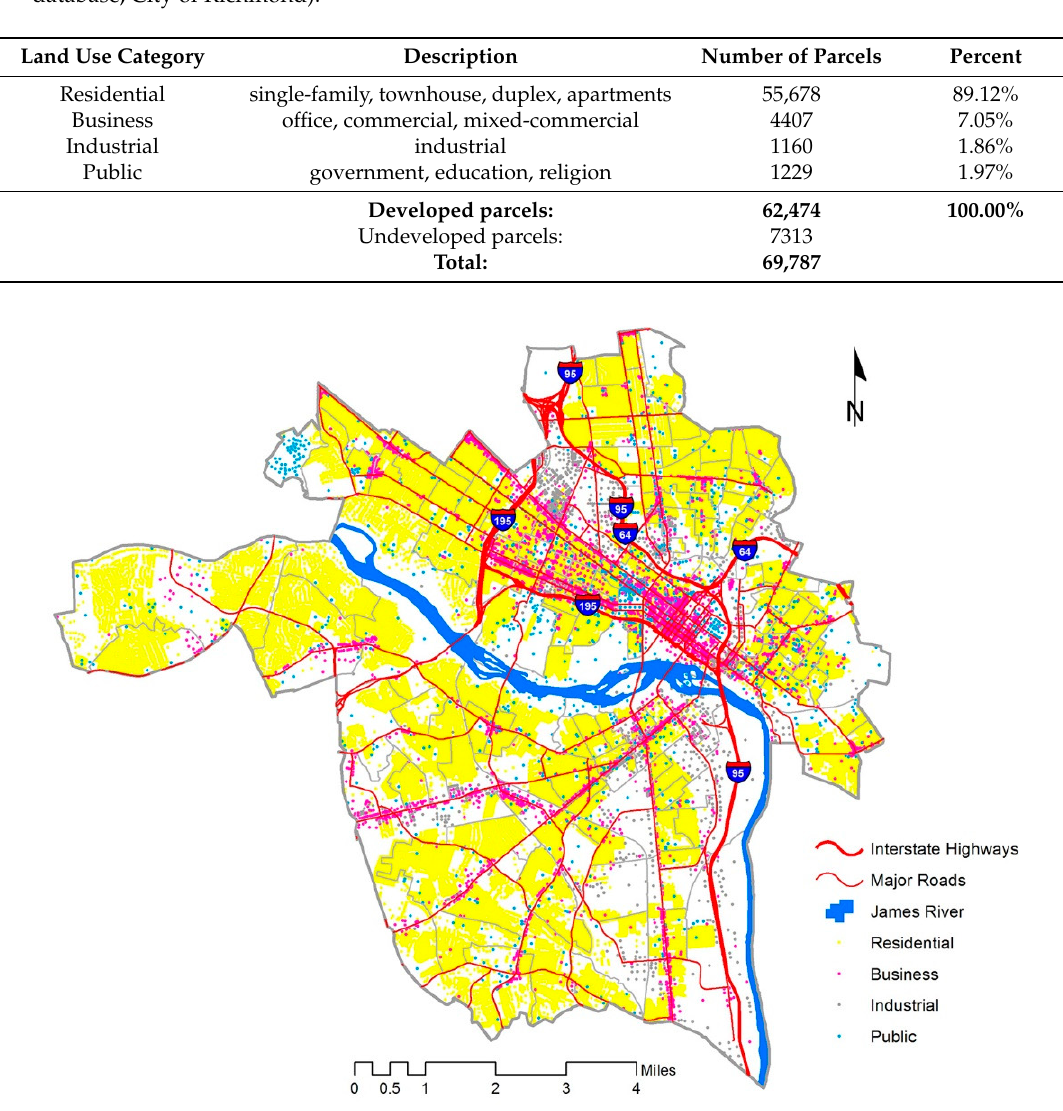
Table 1. Developed parcels by land use categories in Richmond, Virginia (Source: 2014 assessor’s database, City of Richmond).